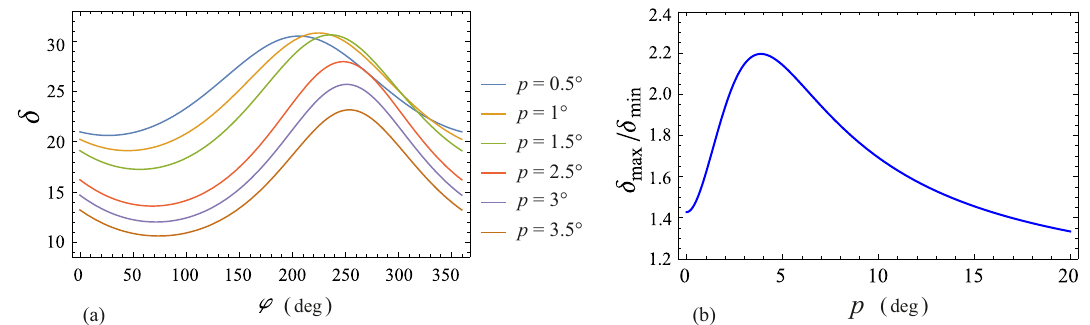
Figure 5. Dependence of the Doppler factor on p : ( a ) Doppler factor versus the azimuth angle for various p and ( b ) ratio of maximum and minimum values of Doppler factor as a function of p